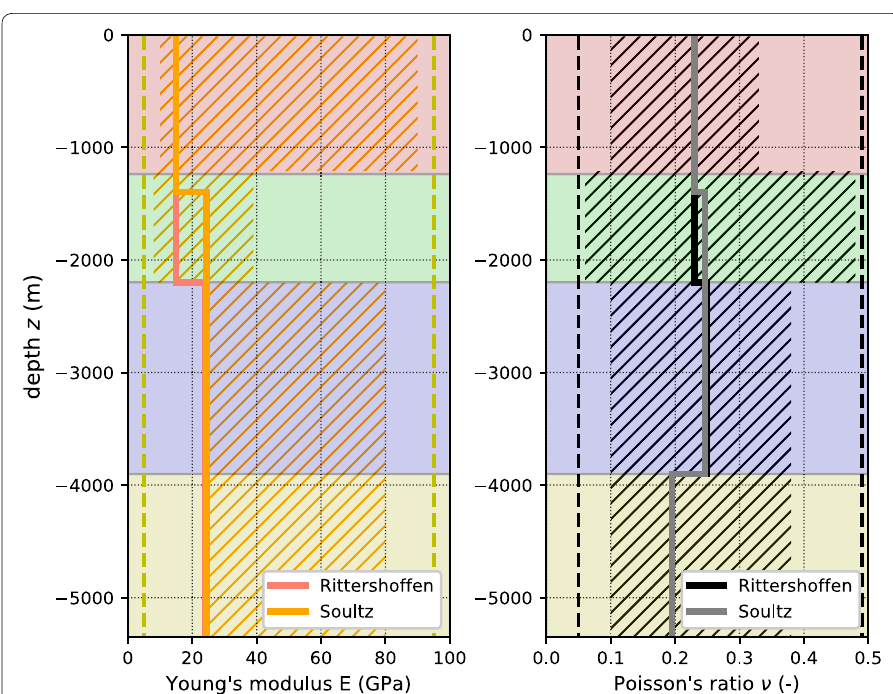
Fig. 6 Comparison of Young’s modulus (left) and Poisson’s ratio (right) between Rittershoffen and Soultz-sous-Forêts sites. The shadow zones correspond to the range of experimental values (Young’s modulus in yellow, and Poisson’s ratio in gray) (see Table 1). The dashed lines correspond to boundaries of the prior distributions for the back analysis (see Table 3). Background colors correspond to geological